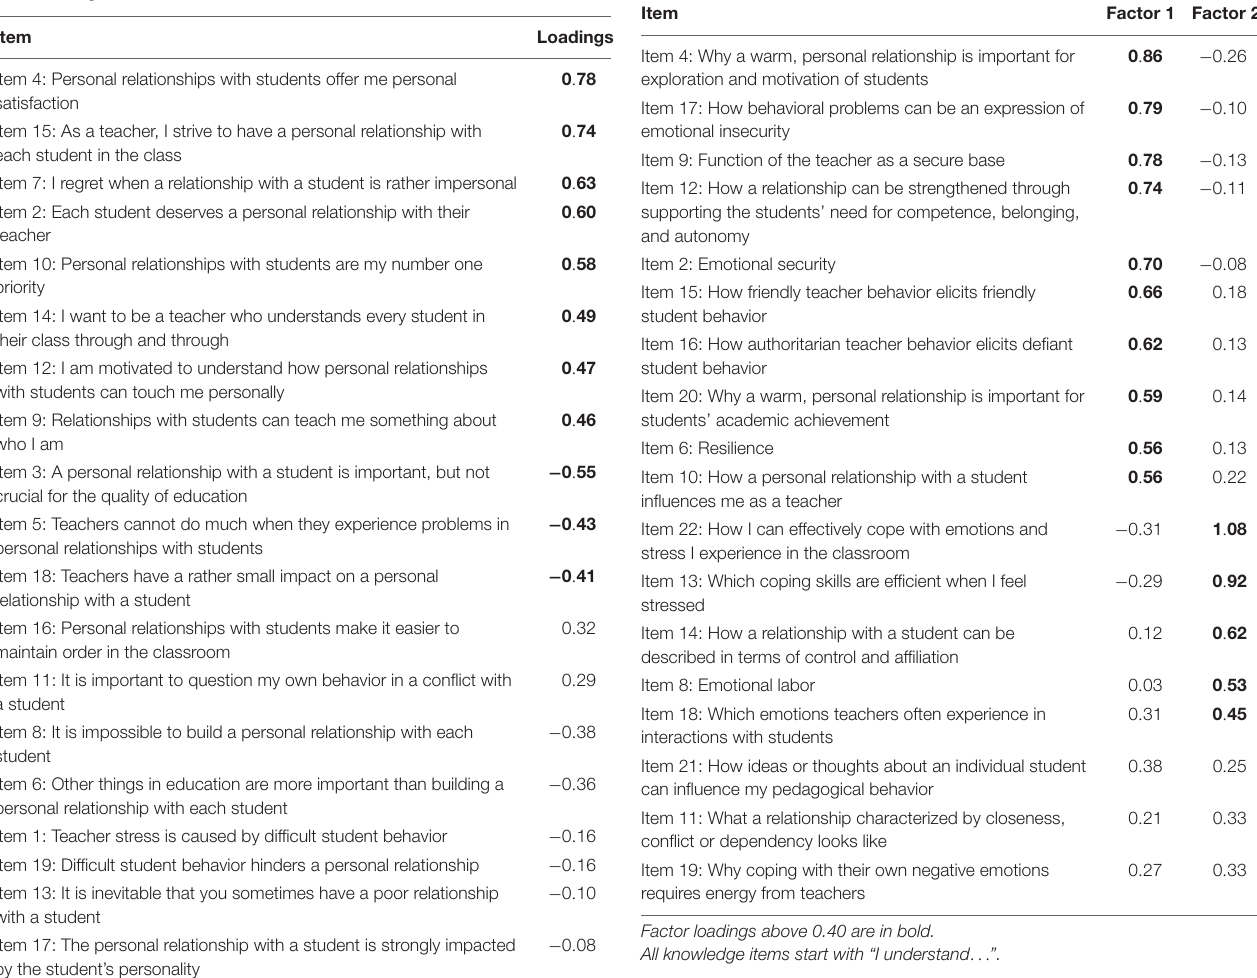
TABLE 2 | Results of exploratory factor analysis for affect-motivation: factor loadings.